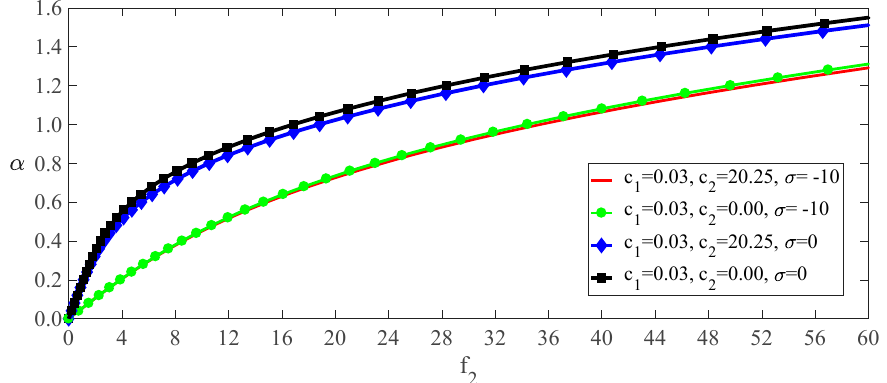
Figure 6. Amplitude of the response as a function of the excitation amplitude of primary resonance